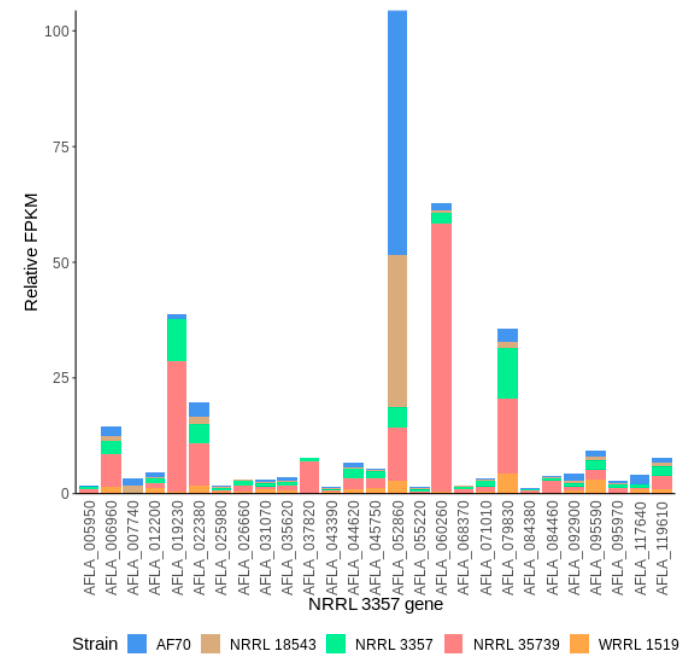
Figure 5. Relative expressions of heat shock and other stress-related genes in five A. flavus strains. Graphs were based on ( A ) AF70 and ( B ) NRRL 3357 alignments. Genes with total relative FPKMs less than 1 were excluded. Gene functional annotations are described in Table 6. J. Fungi 2019 , 5 , x FOR PEER REVIEW